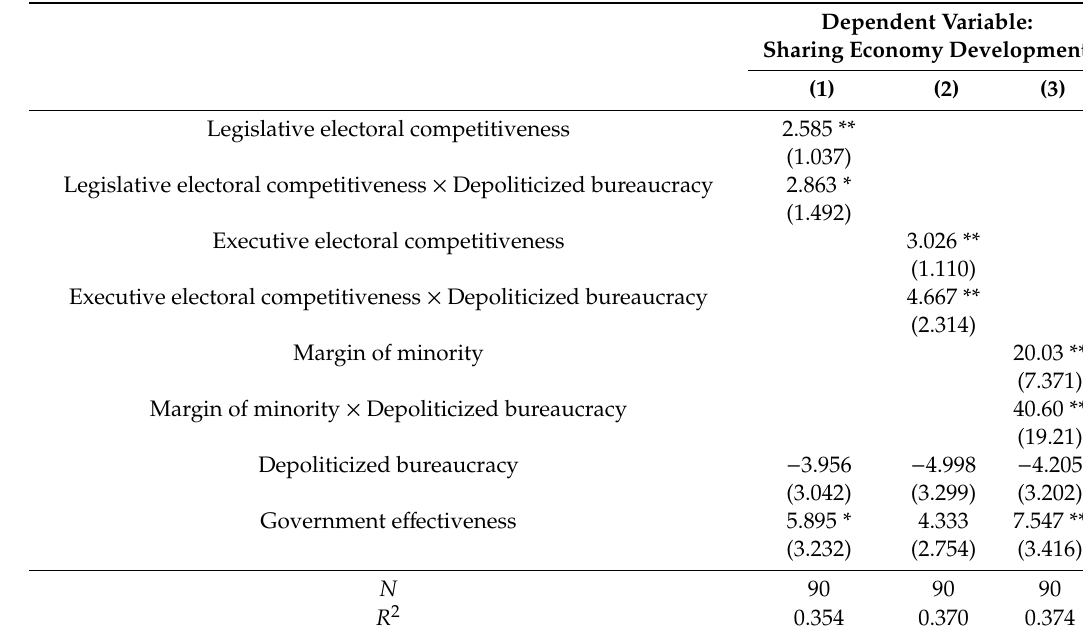
Table 4. Sharing economy development and qualities of government (Hypothesis